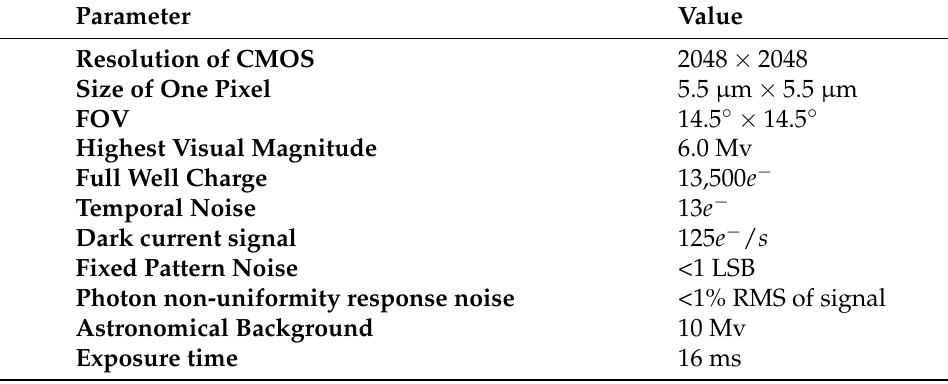
Table 1. Parameters for